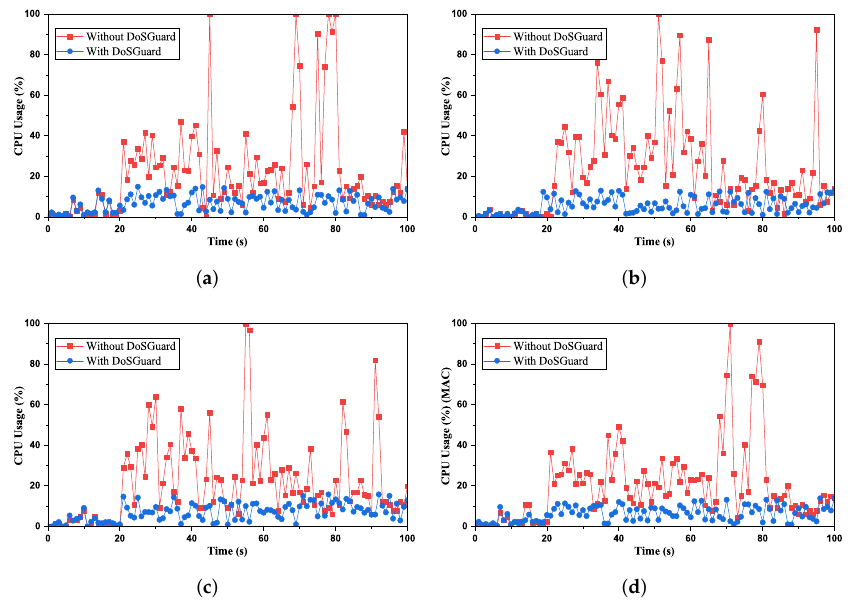
Figure 5. Defense effects on Controller CPU Usage. ( a ) Fake source MAC address. ( b ) Fake source IP